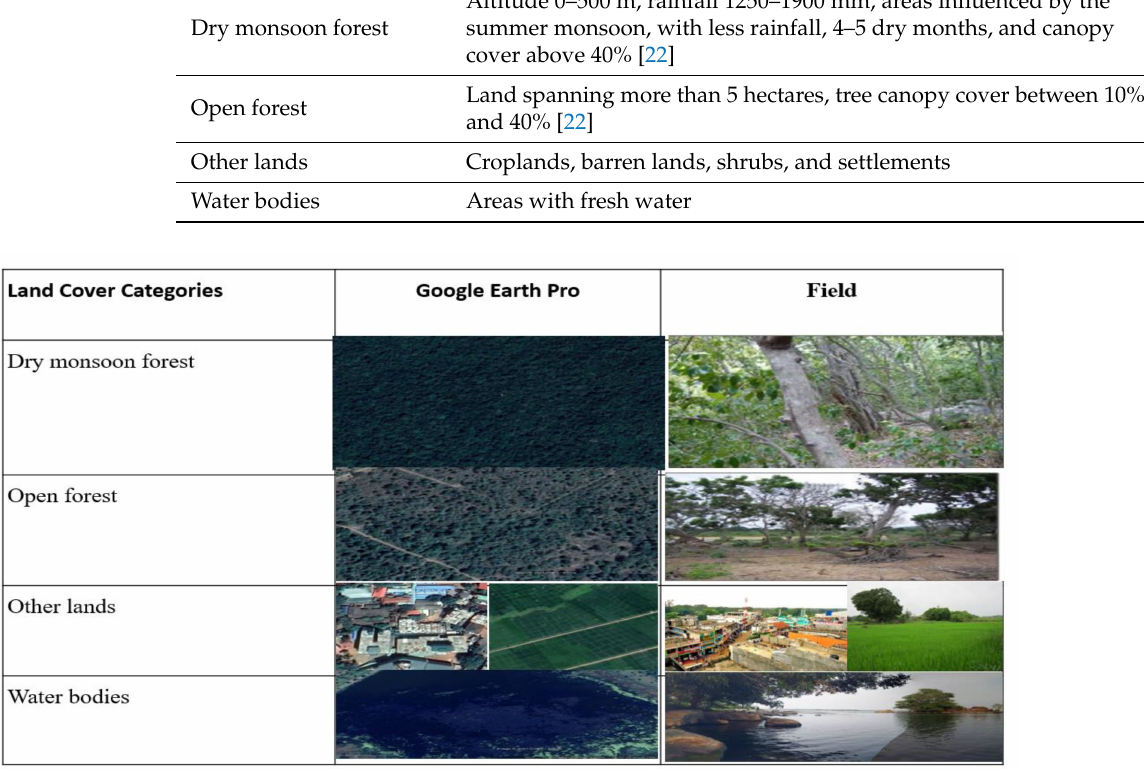
Figure 2. Visualization of land cover categories as shown both on Google Earth Pro and in the field. Table 2. Vegetation thresholds to classify the land cover categories.